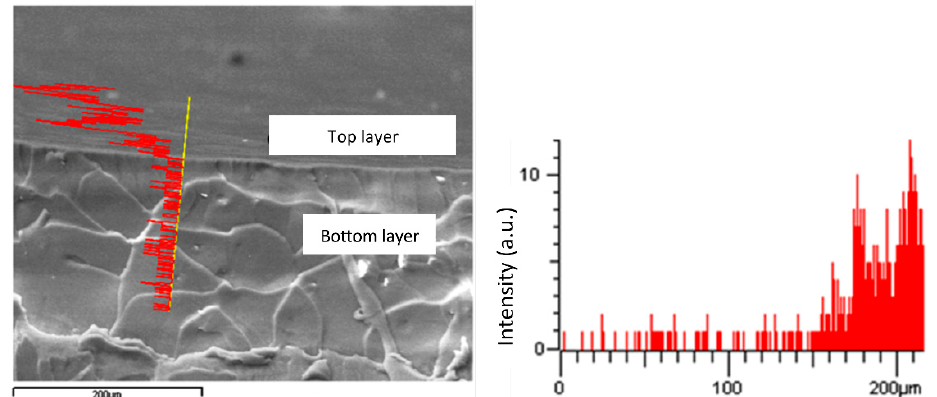
Figure 6. Energy dispersive X-ray EDX analysis of a cryogenic fracture section of a two-layer film (red line indicates fluorine concentration).